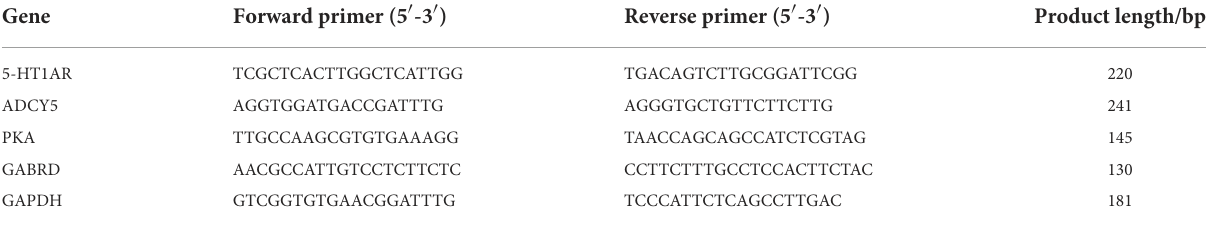
TABLE 1 Primer sequence of internal reference gene in qRT-PCR. Gene Forward primer (5 ′ -3 ′